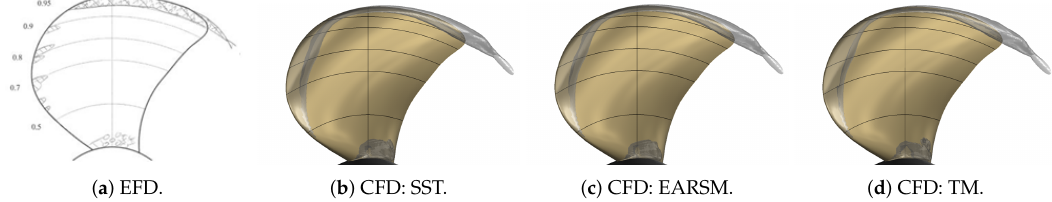
Figure 6. Comparison of model-scale near-blade cavitation observation for the PPTC Case 1. The EFD result is given in [27], and reproduced with permission from Lars Lübke (SVA).